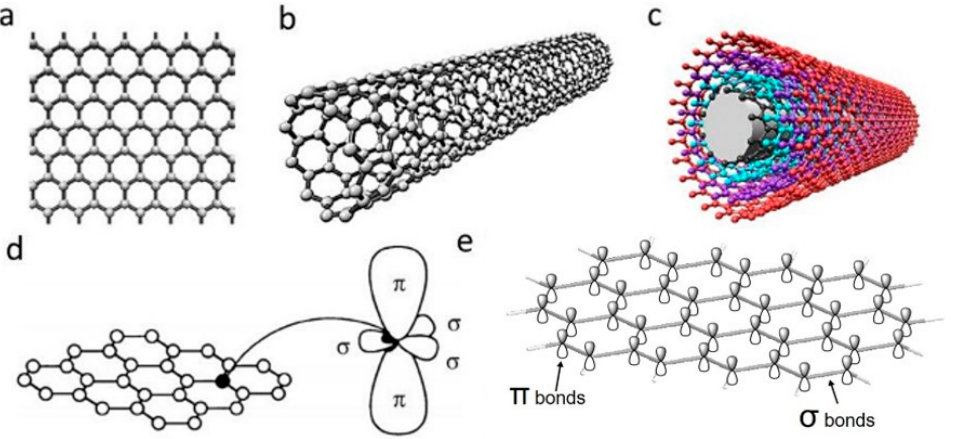
Figure 1. Schematic illustrations of the structures of ( a ) graphene, ( b ) single-walled carbon nanotube and ( c ) multi-walled carbon nanotube. ( d ) σ and π orbitals in carbon sp 2 honeycomb lattice [52]; ( e ) overlapping sigma bonds in sp 2 array of single-layer graphene. Reproduced with permission from Jorio et al., Advanced Materials , published by Wiley-VCH, 2011.